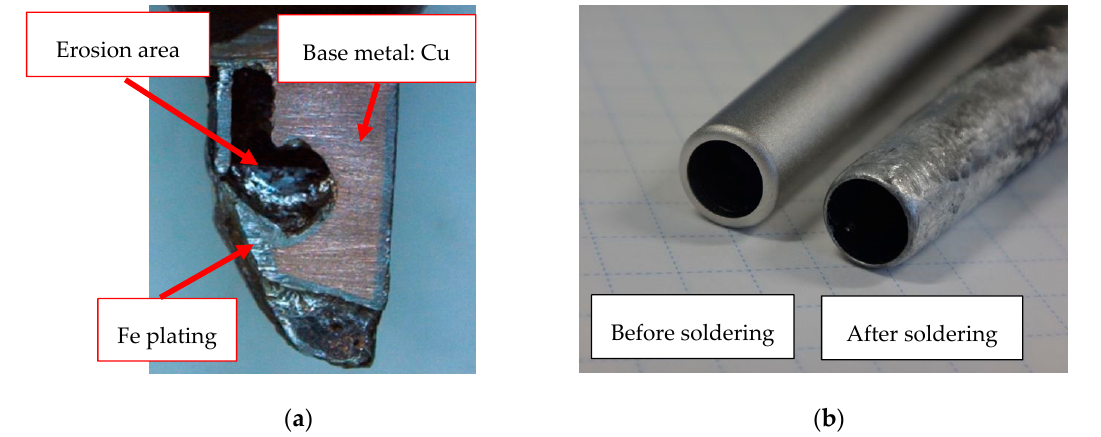
Figure 1. Examples of erosion by molten lead-free solder. ( a ) Erosion of solder iron tip; ( b ) point soldering machine nozzle.